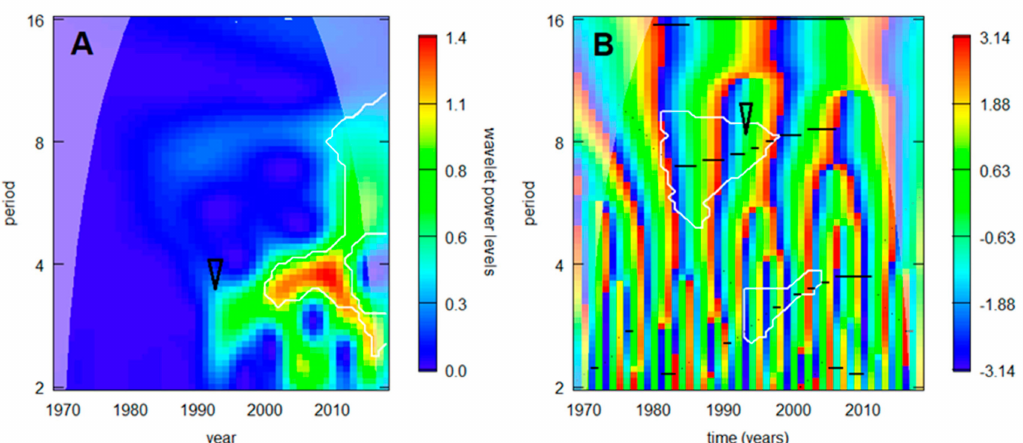
Figure 4. TBE dynamics in the northernmost situated Sweden in terms of ( A ) wavelet power calculated for the incidence series inclusive of trend, and ( B ) image of phases calculated for the stationarized data. White lines delimit domains where the signal exceeds random noise with 95% probability, the darker, ‘cones of influence’ indicate where the analysis is free of edge e ff ects, and black lines in B show ‘ridges’—i.e., trace instantaneous frequencies of the dominating cycles (from the bottom upwards can be seen—quasi-biennial, triennial, and octennial / decadal oscillations). Noticeable is a turn in the 1990s accompanied with sudden increase in power (and lengthening) of the triennial cycle and accelerated prolongation of the decadal cycle